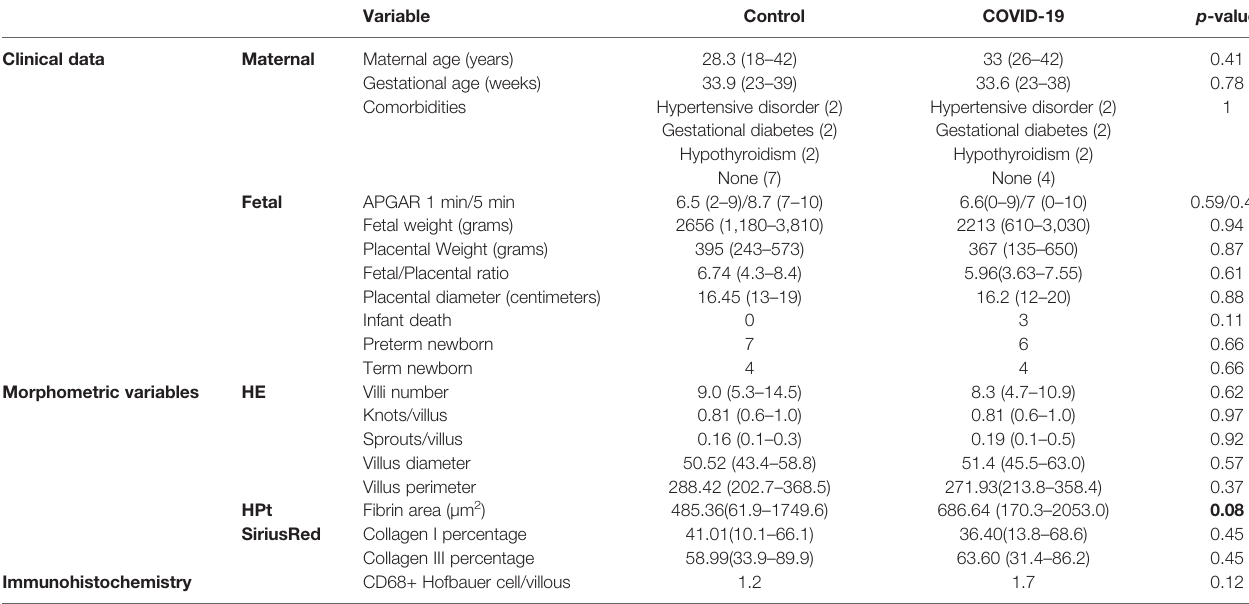
TABLE 4 | Clinical and morphometrical comparisons between COVID-19 group (n=11) and Control group (n=11) placentas.